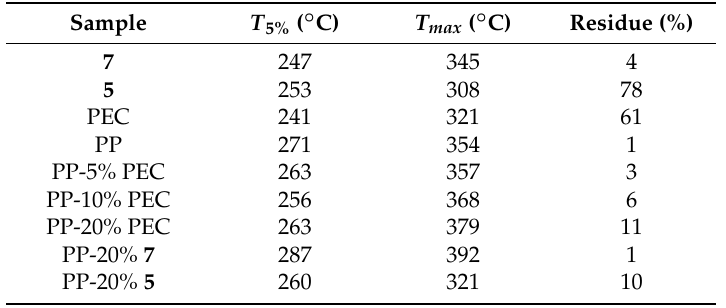
Figure 6. Molecular structure of 7. Table 4. Thermal analysis of polypropylene-polyelectrolyte (PP–PEC) composites.